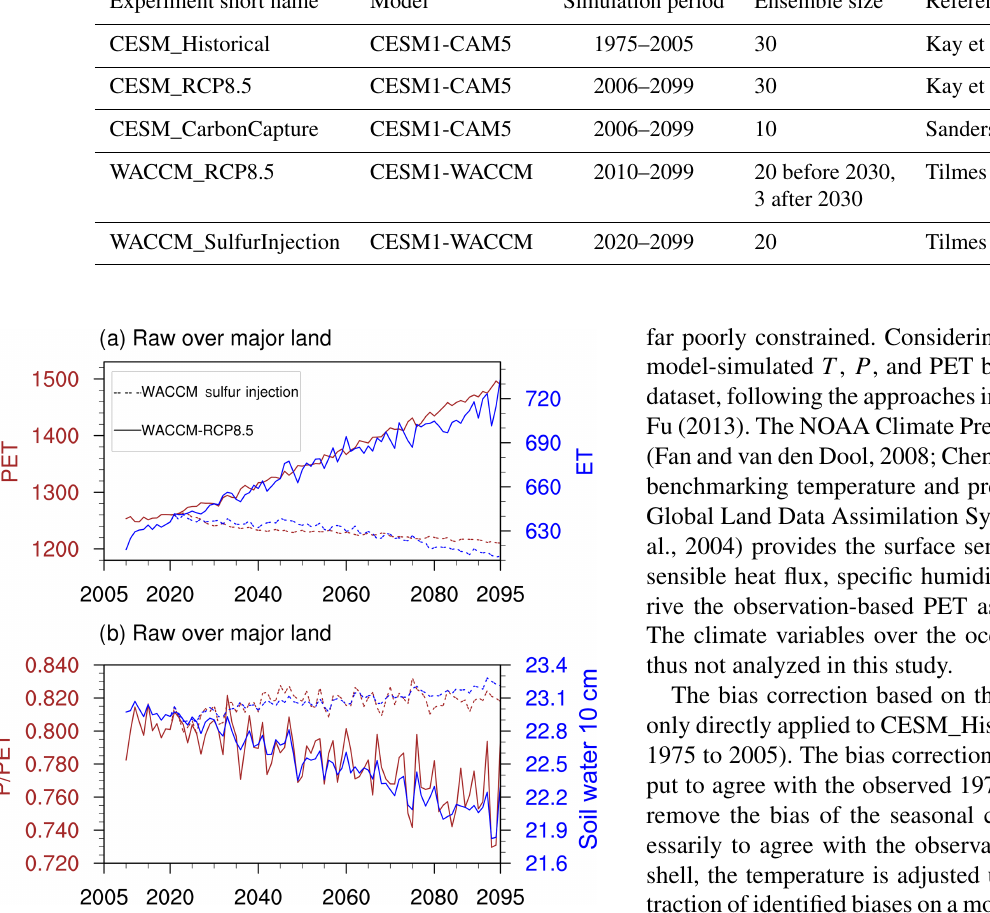
Figure 1. (a) PET (mmyr − 1 ) and ET (mmyr − 1 ) as simulated by WACCM over global major land regions (60 ◦ S to 60 ◦ N) only be- cause P / PET is not a good indicator of drought conditions over snow-covered cold regions. (b) P / PET (unitless) and soil water in the top 10cm layer (mm). The solid lines are for the left y axis and the dashed lines are for the right y axis. Red lines are under RCP8.5 and blue lines are under sulfur injection. Note that no bias correc- tion or smoothing was performed for this figure. CESM results are not shown because (a) there is no reduction of soil moisture in the RCP8.5 warming, and (b) there is no separation of soil moisture in the long-term trends between the RCP8.5 and mitigated warming simulations, presumably due to model deficiency outside the Amer- icas because within the Americas (Fig. 2), the CESM results are largely consistent with